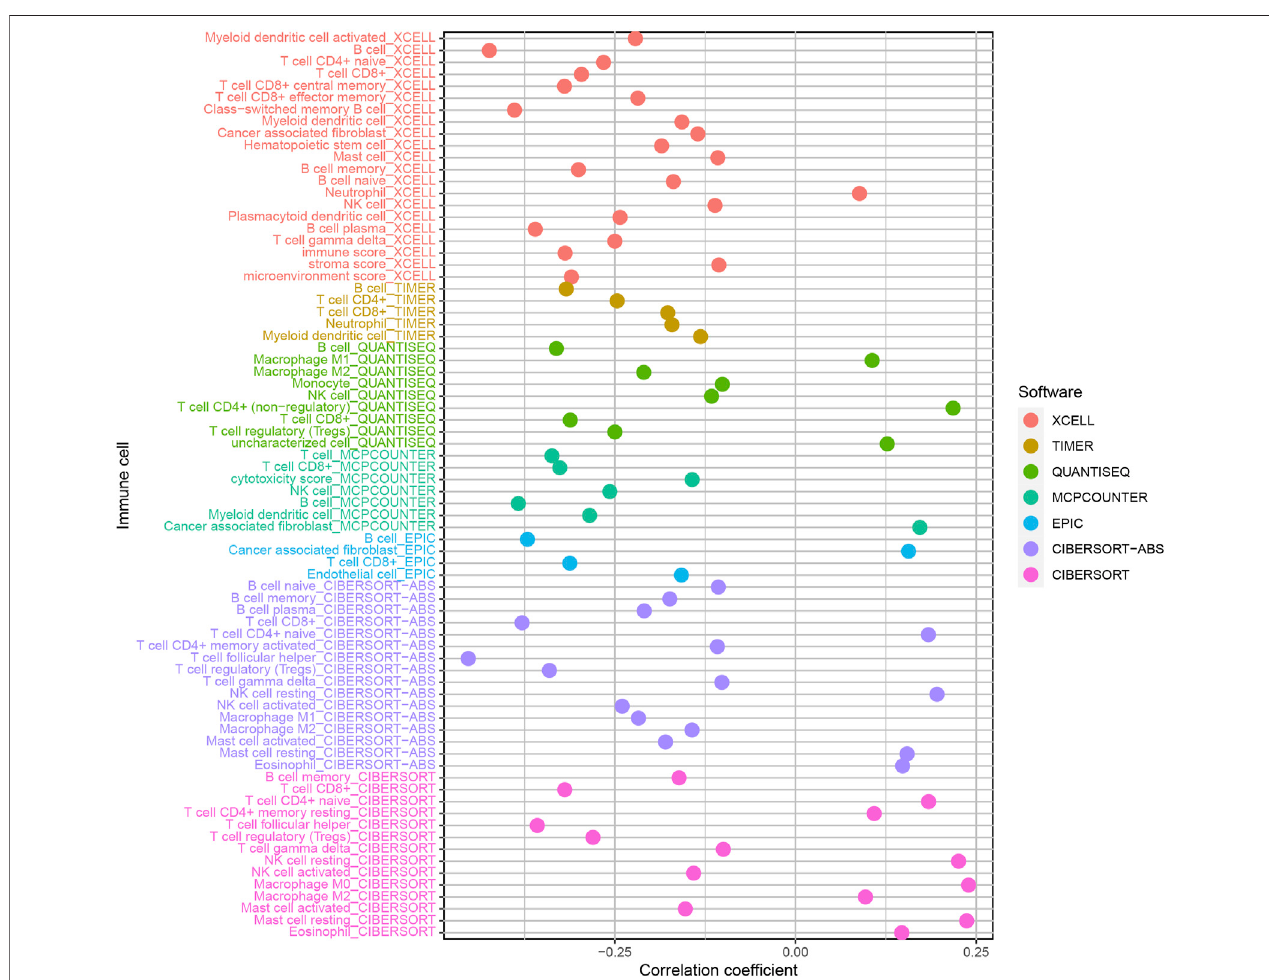
FIGURE5| Estimationoftumor-in fi ltratingcells.Thehigh-riskgroupinthemodelhadsigni fi cantnegativerelationshipswithimmunein fi ltrationofBcells,mastcells, myeloid dendritic cells, NK cells, regulatory T cells, CD4 + T cells, and CD8 + T cells.